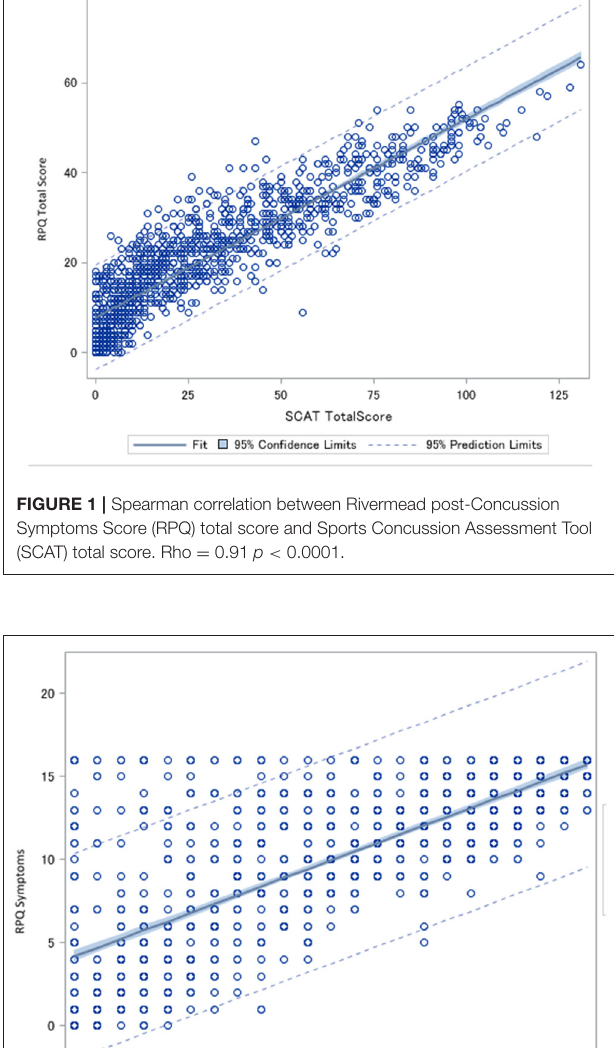
symptom groups of the SCAT and RPQ was rho = 0.88 ( P < 0.0001) and when fatigue was not included as a somatic symptom, the groups’ correlation was rho = 0.87 ( p < 0.0001). The Cognitive symptoms groups had a correlation of 0.83 ( p < 0.0001), the Emotional symptoms groups had a correlation of rho = 0.85 ( p < 0.0001), and the Sleep symptoms groups had rho = 0.74 ( p < 0.0001). The symptoms included in each domain grouping is presented in Table 1 .